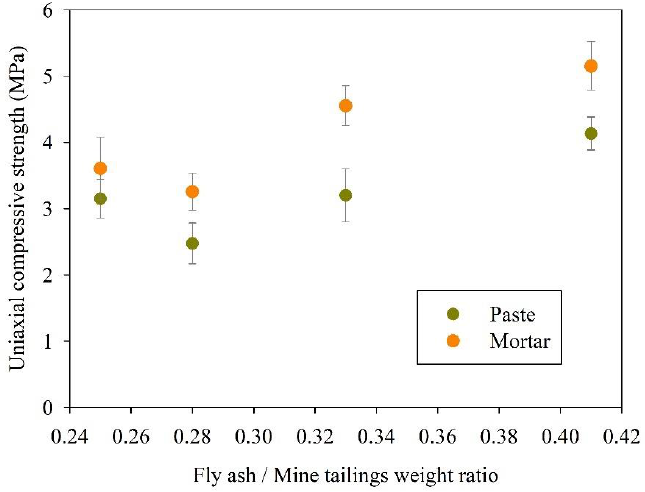
Figure 4. Influence of the ash/tailings weight ratio on compressive strength. Appl. Sci. 2020 , 10 , x FOR PEER REVIEW